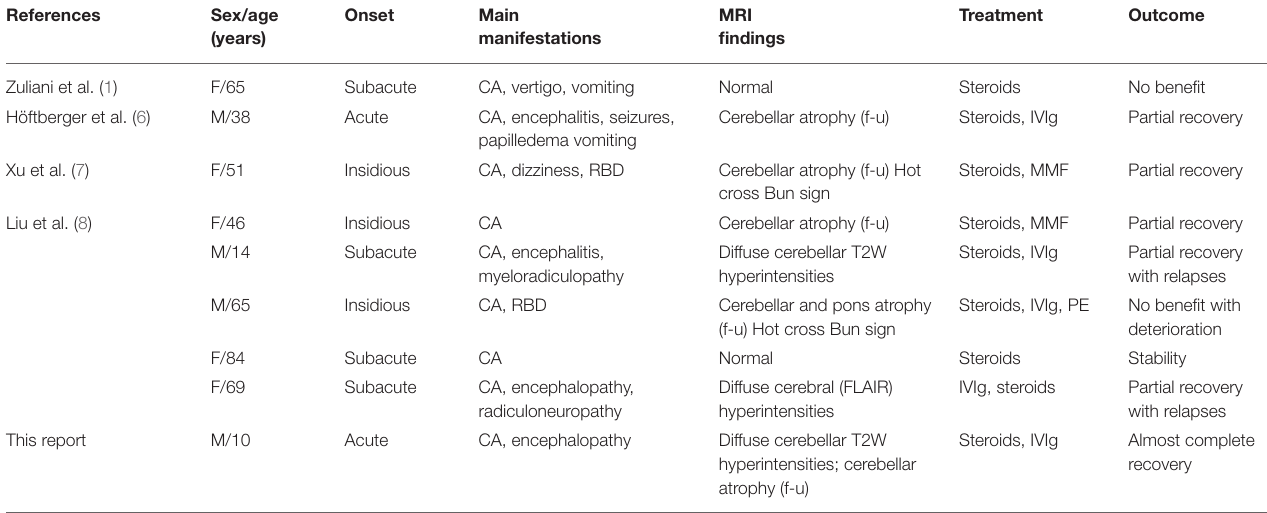
TABLE 1 | Summary of reported clinical cases of anti-Homer-3 associated autoimmunity.